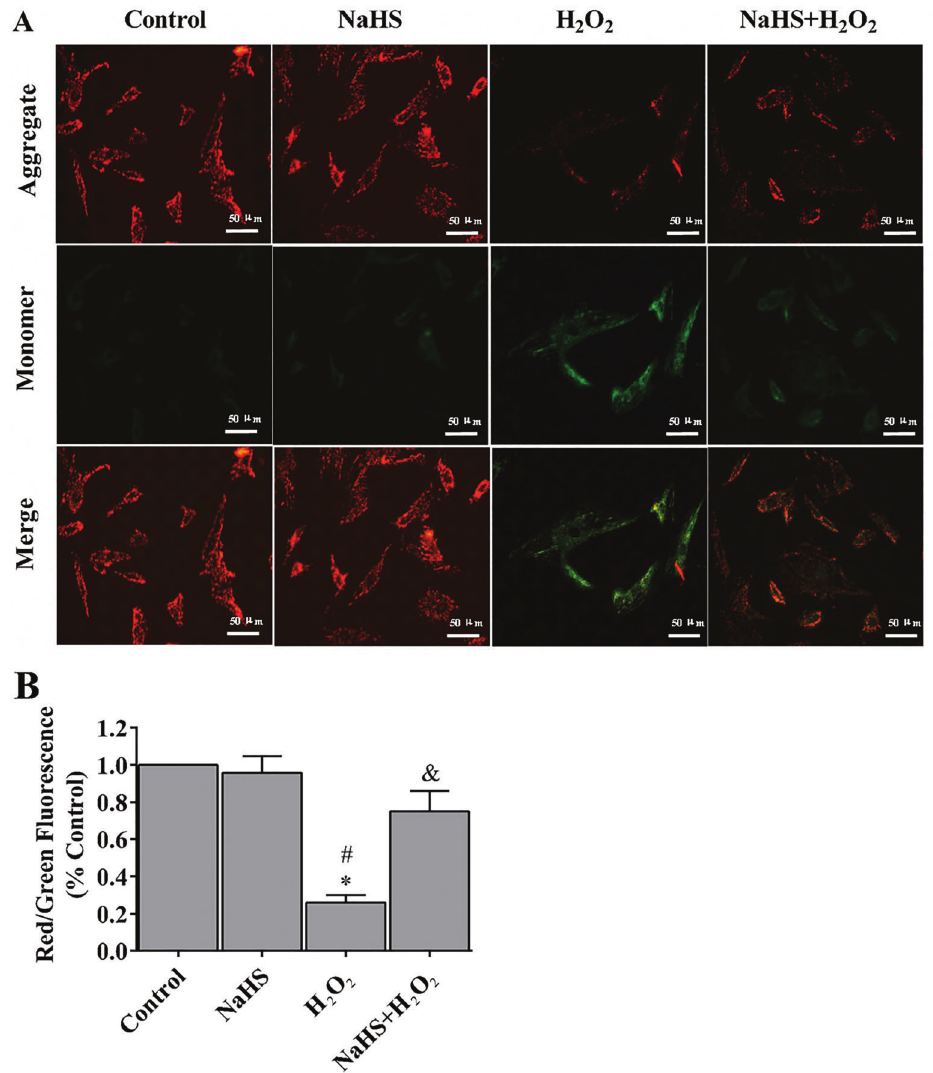
Figure 3. Hydrogen sul fi de (H 2 S) prevented the loss of mitochondrial membrane potential ( c m ) ( A ). The c m loss was determined by the lipophilic cationic probe JC-1. Red signal indicates JC-1 in mitochondria and green signal indicates cytosolic JC-1. Magni fi cation (cid:1) 400; bar: 50 m m. B , Quantitative analysis of membrane potential. Data are reported as means ± SE (n=6). *P o 0.01 vs control; # P o 0.01 vs NaHS; & P o 0.05 vs